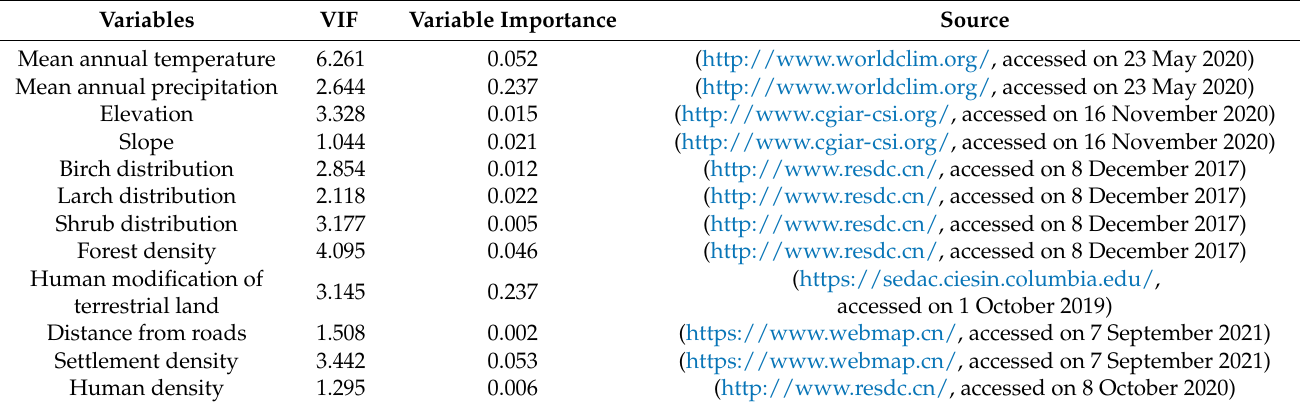
Table 1. Variance inflation factor value, environmental variable importance, and data